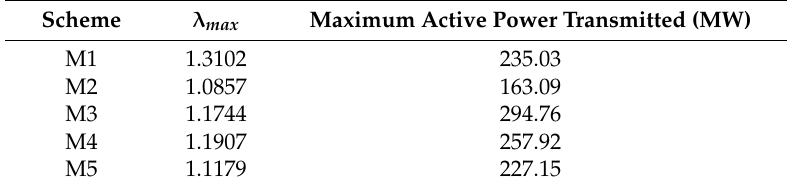
Table 4. Maximum load growth factor and maximum active power transmitted in AC